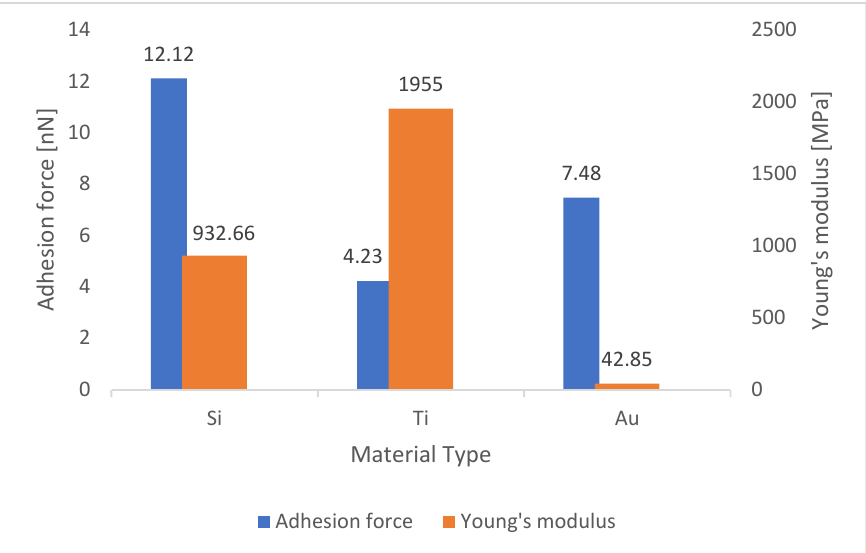
Figure 5. Comparison of values of Young’s modulus with adhesion force in the gold surface.